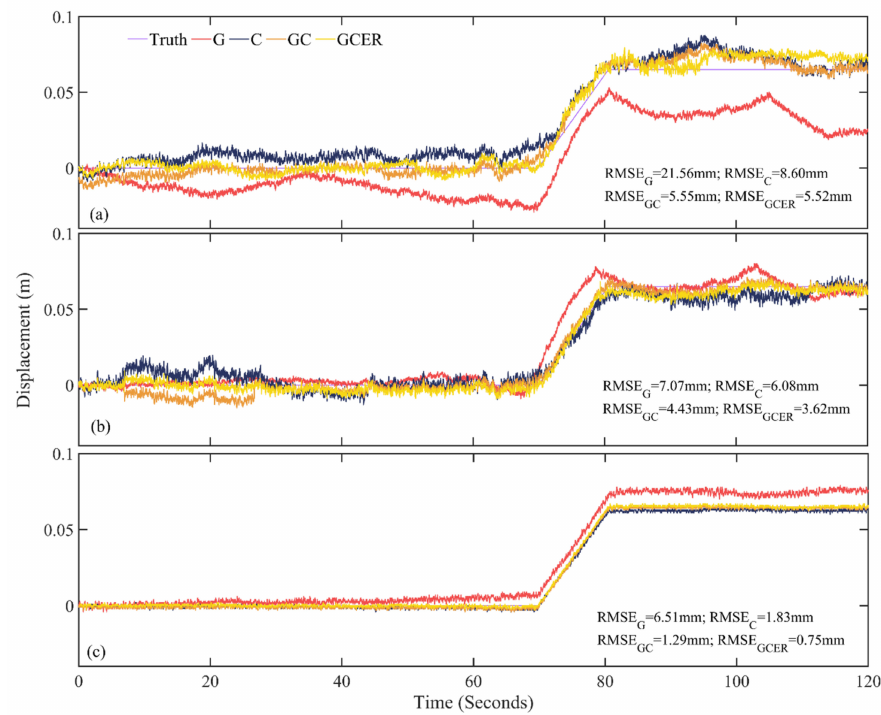
Figure 5. Displacement time series from the quasi-static motion test computed with observations from the different satellite systems and ( a ) PPP, ( b ) PPP-AR, ( c ) and RTK techniques (starting from 08:26:00 GPST).